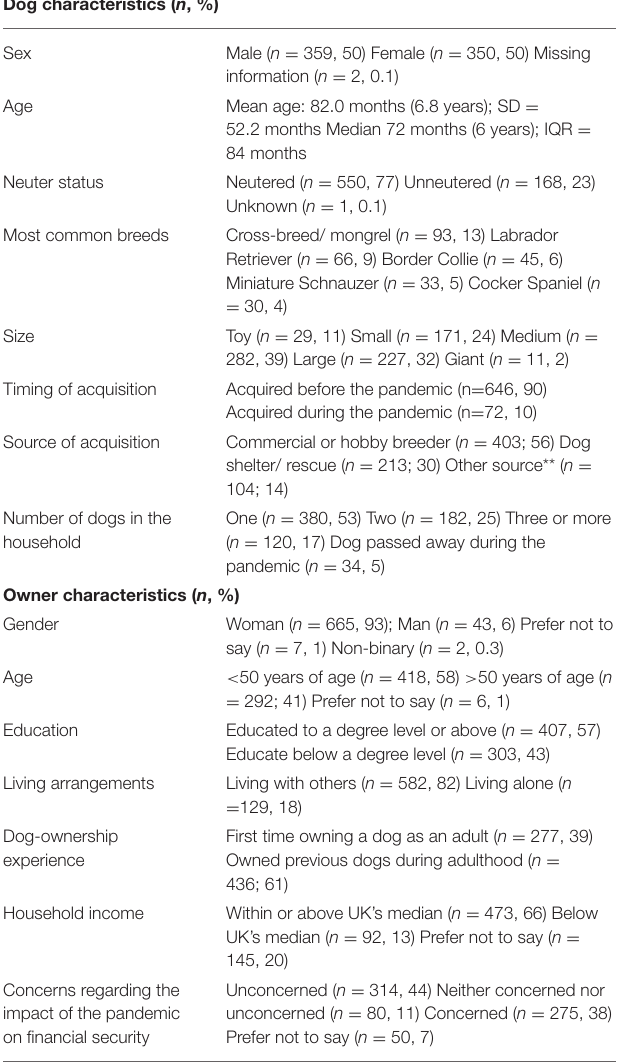
TABLE 2 | Dog and owner characteristics. Dog characteristics ( n ,